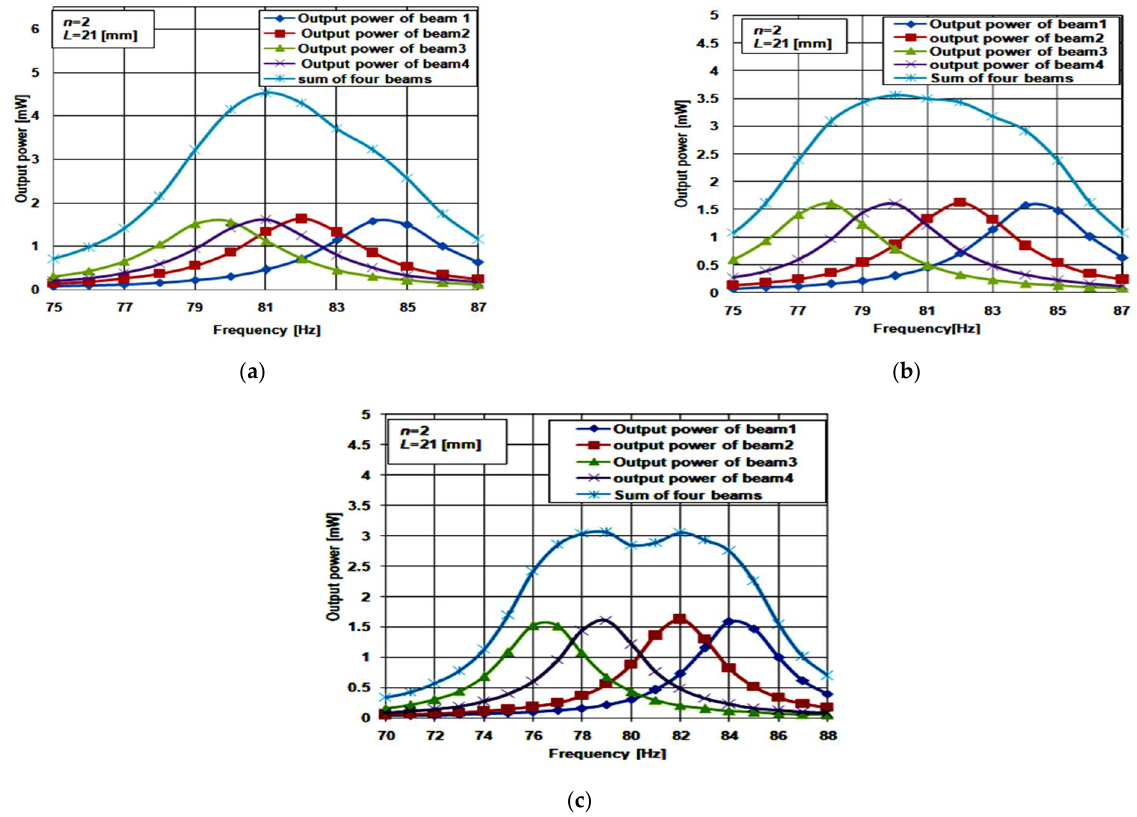
Figure 8. Frequency response of four beams array case 1: ( a ) first case where L 1 for beam 3 and beam 4 equal to 4 and 5 mm; ( b ) second case where L 1 for beam 3 and beam 4 equal to 5 and 7 mm; and ( c ) third case where L 1 for beam 3 and beam 4 equal to 6 and 9 mm.